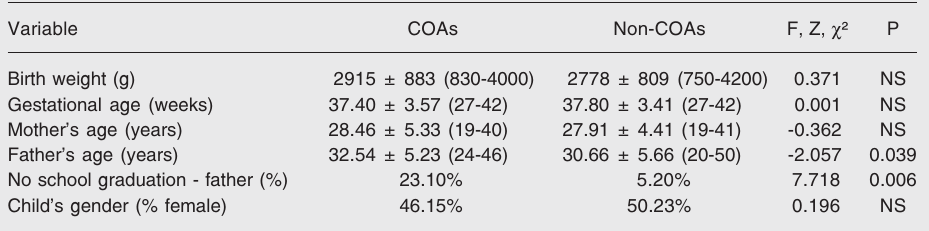
Table 1. Neonatal and demographic characteristics of children of alcoholic fathers (COAs; N = 26) and of the control group (non-COAs; N =